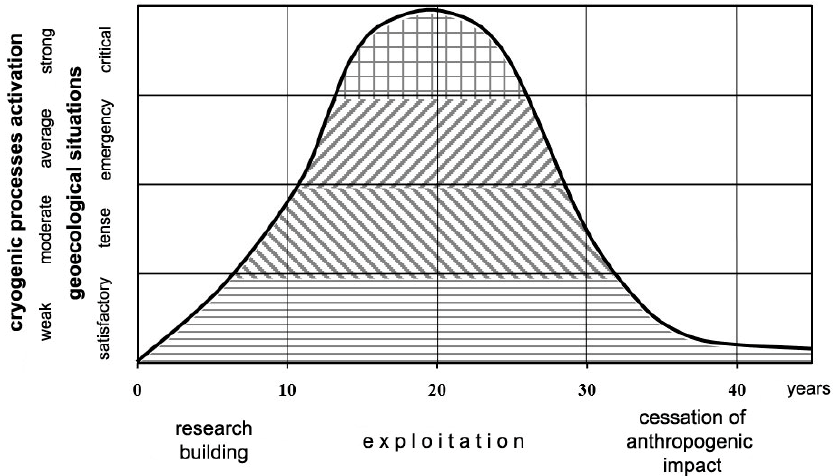
Figure 11. Types of geoecological situations depending on the stages of development and intensity of cryogenic processes manifestation.